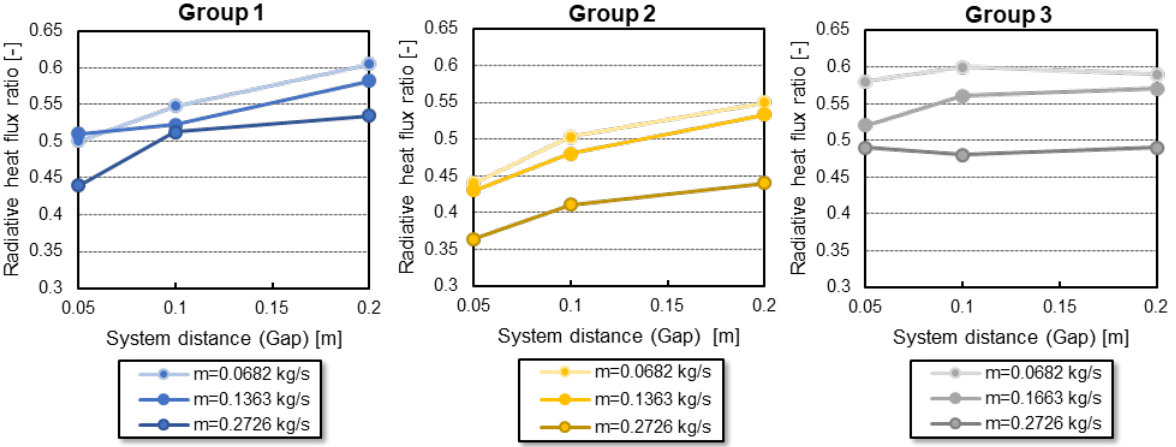
Figure 13. Evolution of the radiative heat flux ratio with system gap distance for different inlet mass flow rates (Configuration 2).